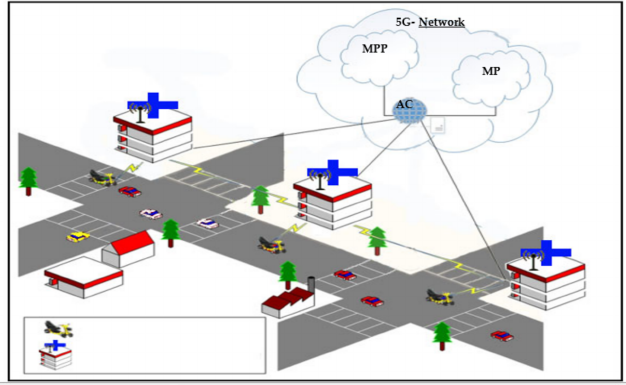
Figure 3. The scheme of the telemedicine network, features, and